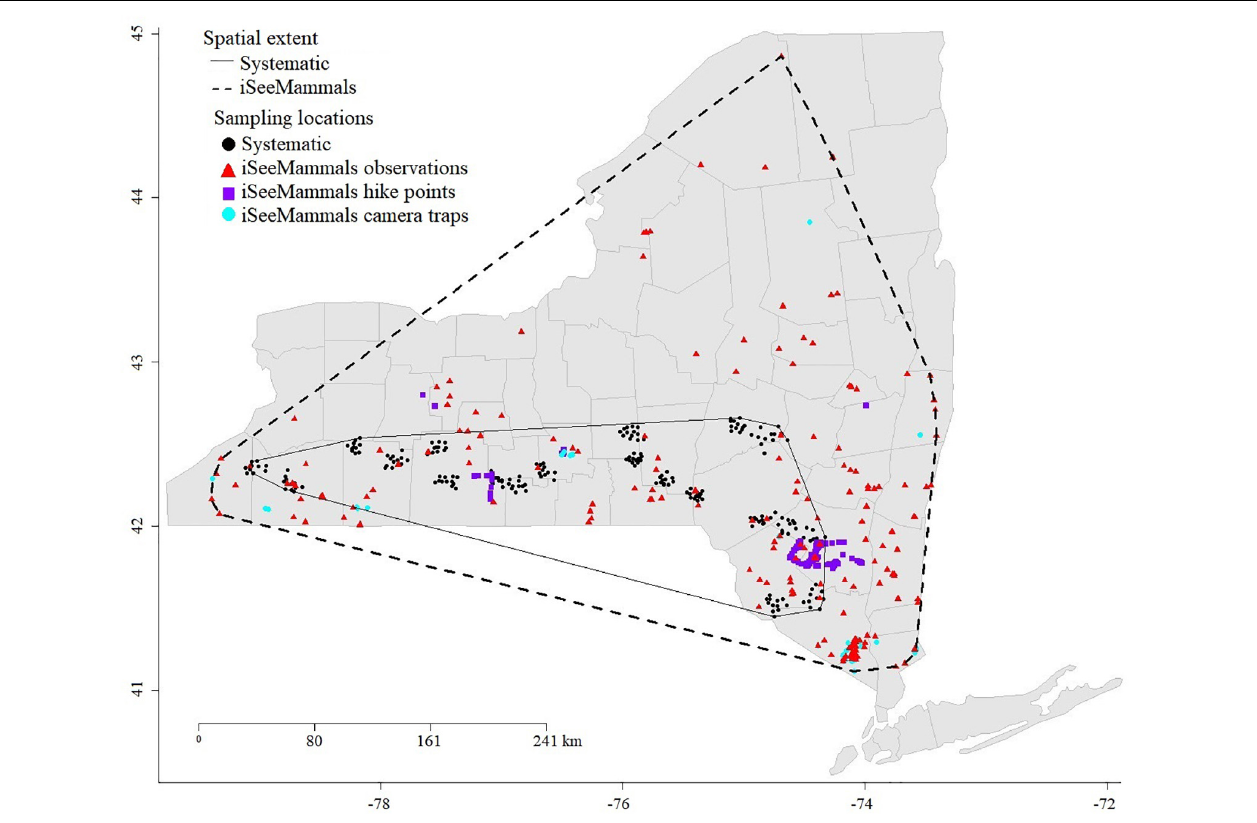
FIGURE 2 | Location of iSeeMammals one-off observations, hikes, and camera traps collected between 1 January 2017 and 31 October 2017 across New York state. Also shown, in black dots, are the location of 241 systematic SCR sites deployed from June to August, 2017. Light gray lines indicate county borders. The minimum convex polygons for the systematic (40,079 km 2 ) and iSeeMammals (113,392 km 2 ) sampling highlight the value of citizen science data for increasing spatial extent and quantity of data that can be collected. Coordinates shown in latitude and